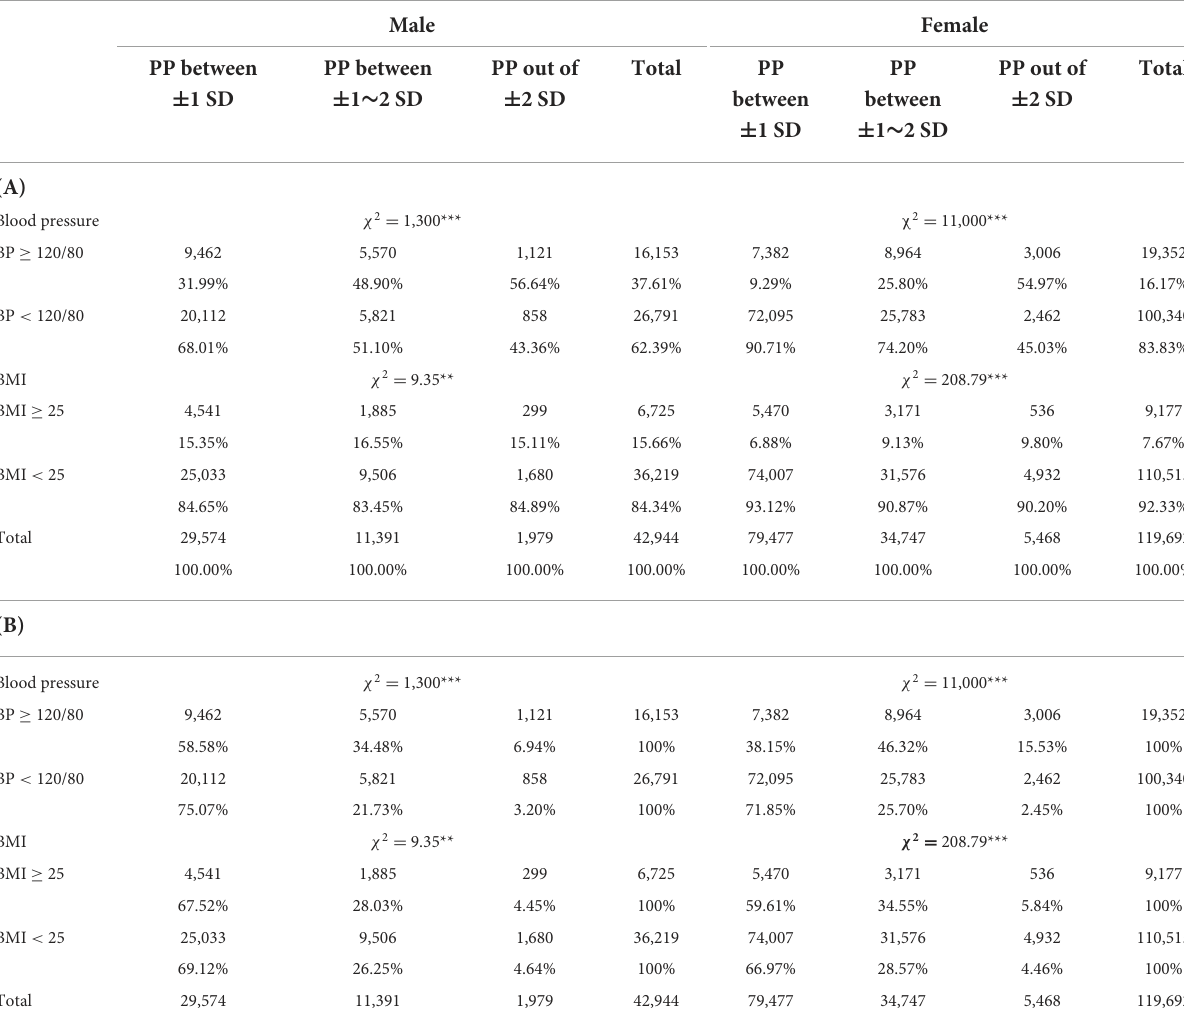
TABLE 3 Pulse pressure (PP) significantly correlates with health metrics, BMI < 25 kg/m 2 and BP < 120/80 mmHg.